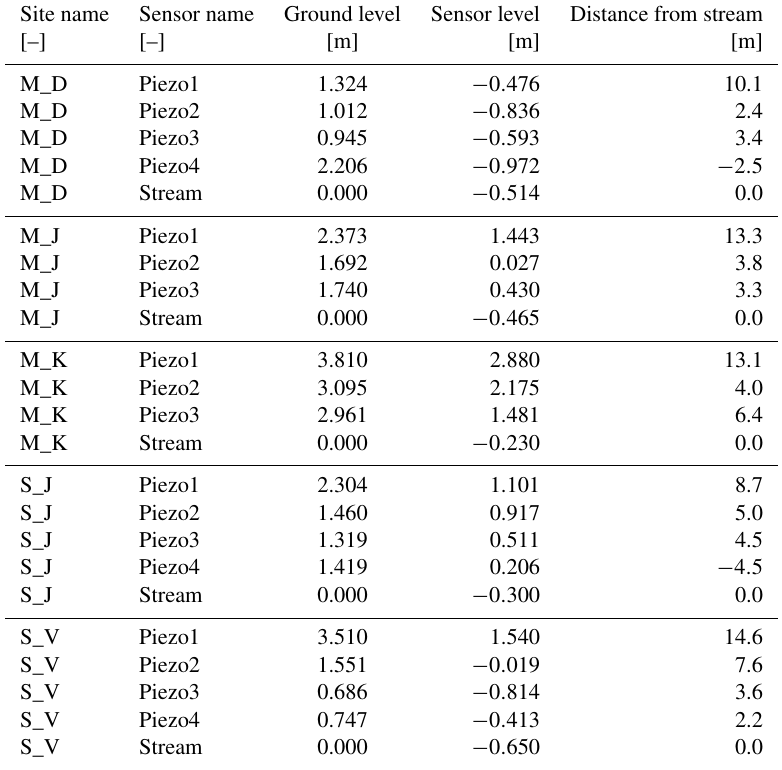
Table A2. Spatial information for the